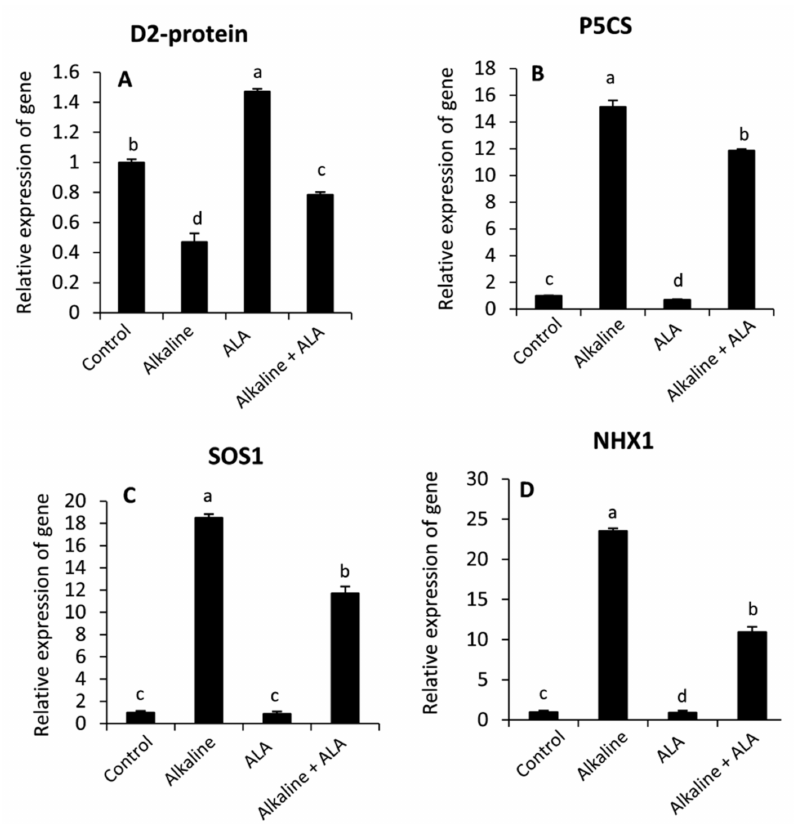
Figure 7. Effect of exogenous α -lipoic acid (ALA; 20 µ M) on the relative expression of photosystem II D2 protein; PsbD ( A ), Pyrroline-5-carboxylate synthase; P5CS ( B ), plasma membrane Na + /H + antiporters protein of salt overly sensitive gene; SOS1 ( C ) and tonoplast-localized Na + /H + antiporter protein; NHX1 ( D ) using quantitative real time PCR in the leaves of wheat seedlings grown under sodic alkaline